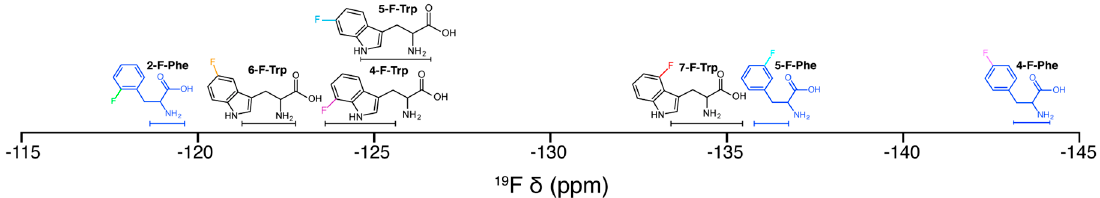
Figure 8. Observed chemical shift ranges for F substituents on 2,4,5-trifluorophenylalanine in F*-ap- 13 and 17 (blue) and for each indicated F-Trp for AR55 and TM1-3 [33], and for 5F-Trp more generally